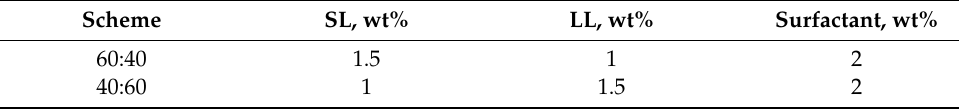
Table 3. Composition of NLC formulations with two SL:LL